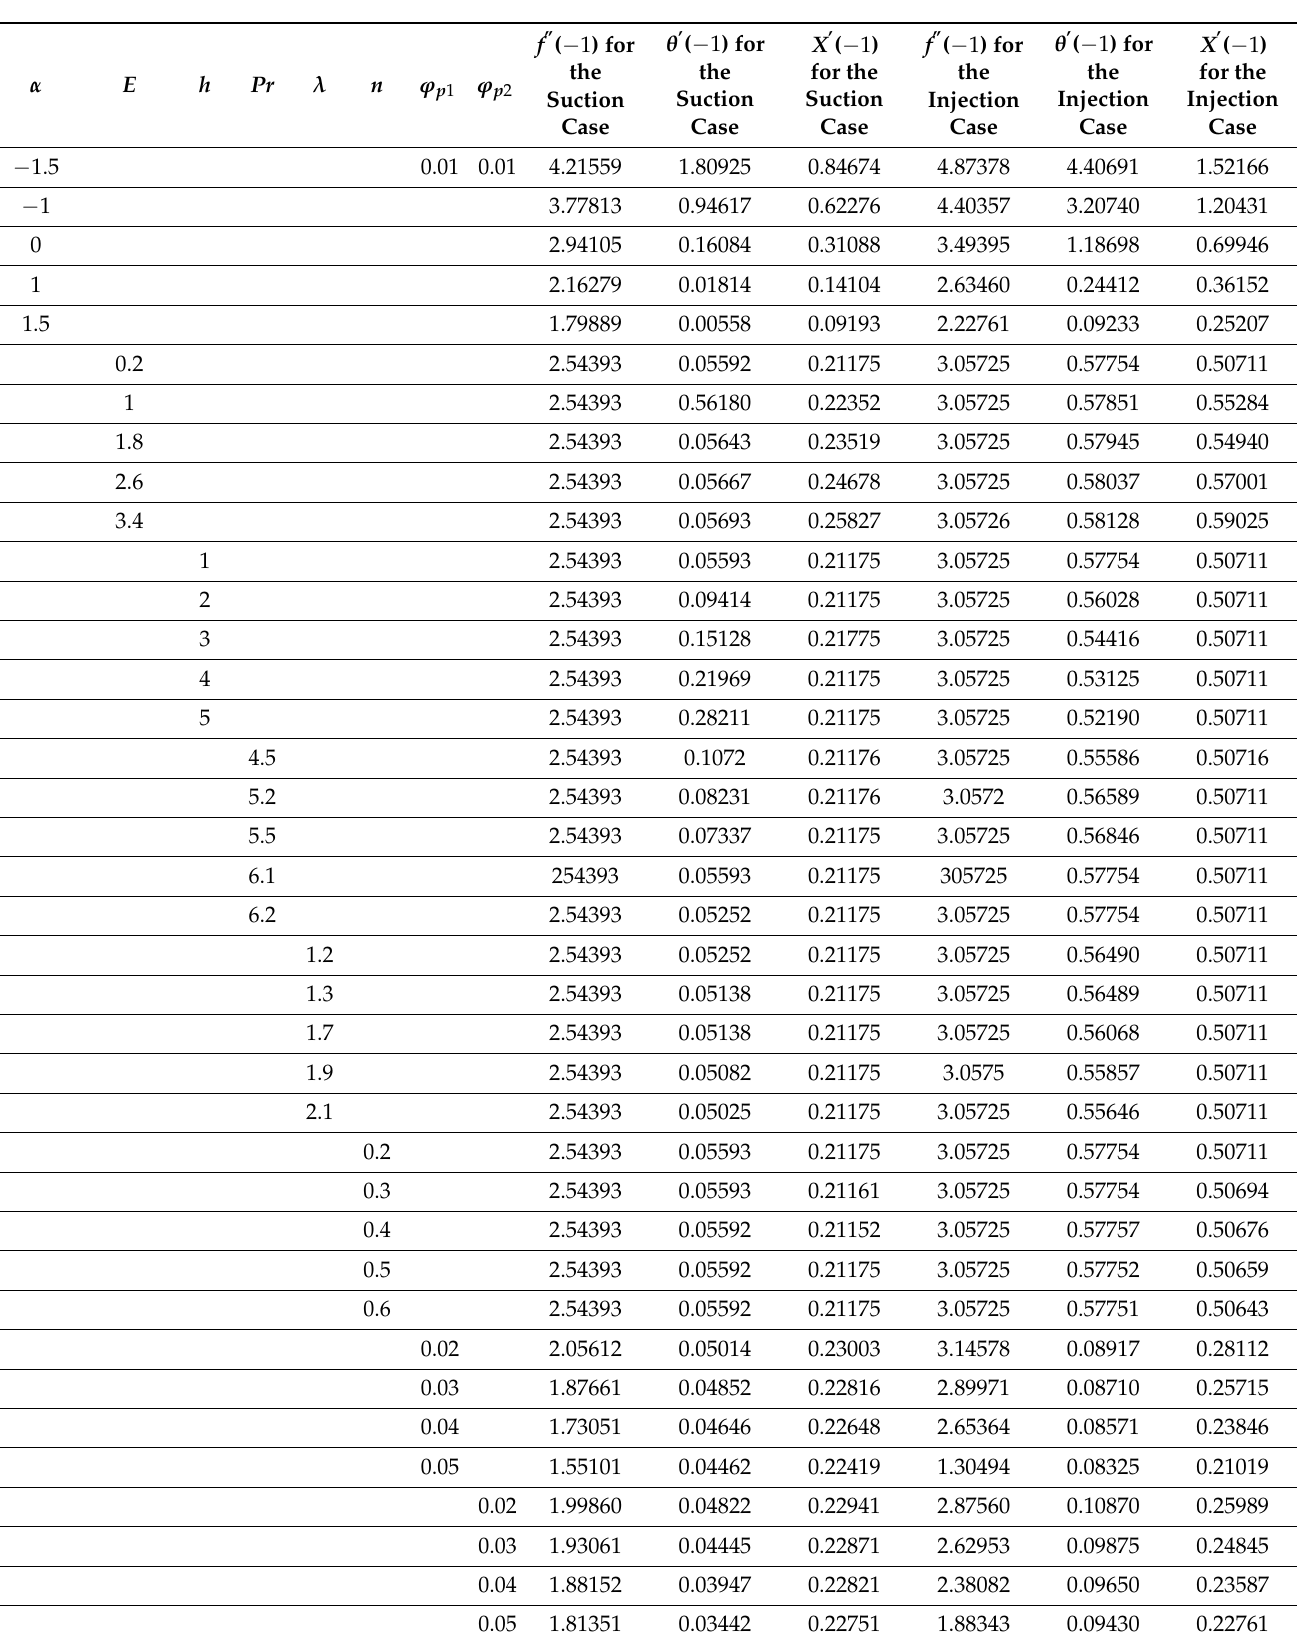
Table 3. Variation in shear stress, heat, and mass transfer rate for suction and injection cases at the lower